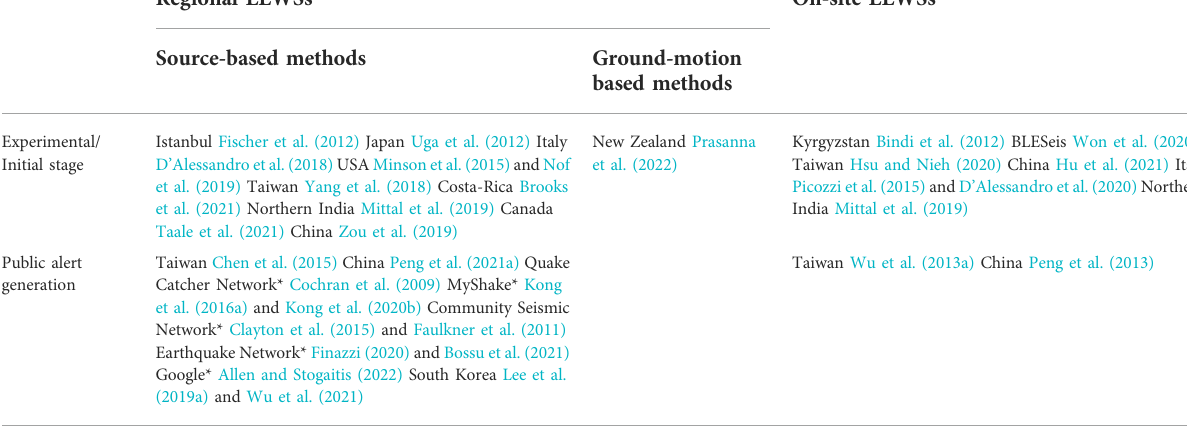
TABLE 2 Summary of articles reviewed according to their warning type and EEW